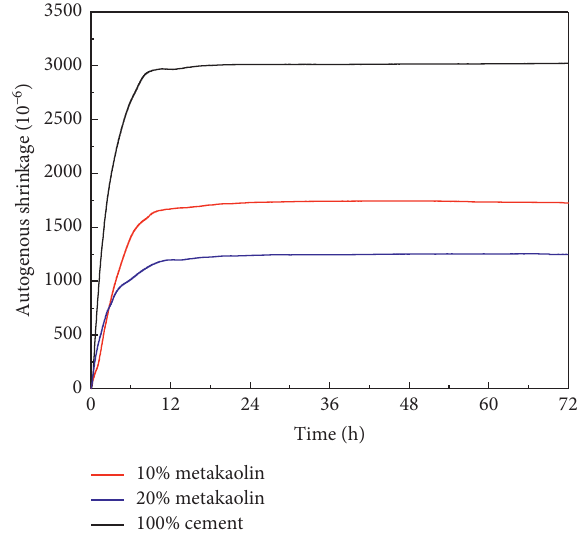
Figure 14: Effect of PCE-2 and slag dosage on autogenous shrinkage of cement